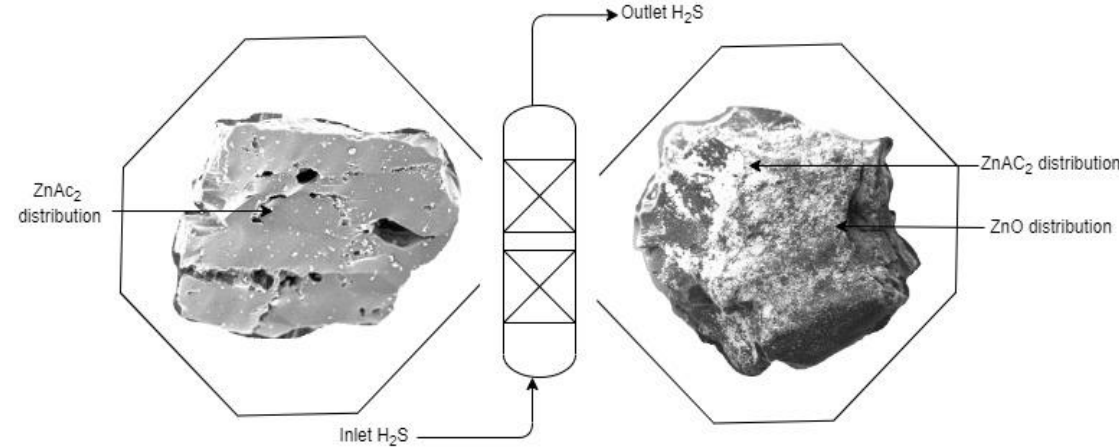
Figure 4. Differences in the distribution of chemicals on the surface of adsorbents.